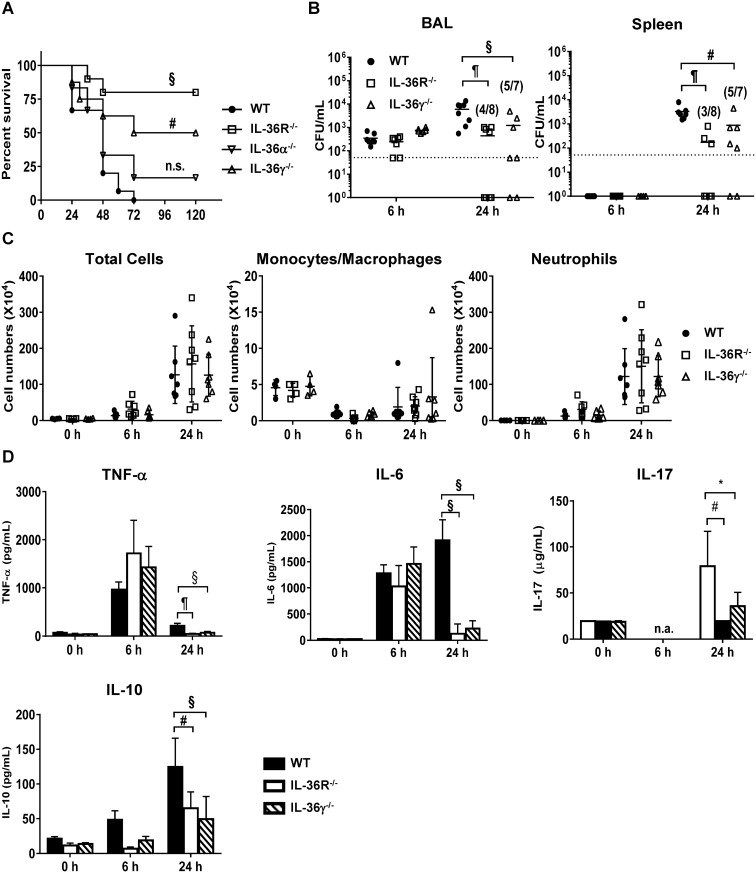
IL-36 receptor and IL-36γ deficient mice were resistant to acute P. aeruginosa infection.WT, IL-36 receptor deficient (IL-36R-/-) and IL-36γ deficient (IL-36γ-/-) mice were intratracheally infected with 2.0 × 105 CFU P. aeruginosa. (A) Survival rate were assessed every 12 h following P. aeruginosa infection. Each group consisted of 6–10 mice. Survival curves were analyzed using the log-rank (Mantel–Cox) test. (B) Bacterial burden in BAL (left upper) and bacterial dissemination in spleen (left panel) were assessed by subsequent dilution method (n = 6–8 per each group). 50 CFU/mL is the limit of detection. Horizon bar indicate mean values. (C) The number of total cell (left panel), neutrophils (middle panel) and monocytes and macrophages (right panel) in BAL were counted at 0 h, 6 h and 24 h after infection. Each group consisted of 4–8 mice. (D) The production of TNF-α, IL-6, IL-10 and IL-17 were measured by ELISA (n = 4–8 each group). (C, D) Data are shown as mean (B) or means ± SD. # p<0.01, § p<0.001, ¶ p<0.0001, n.s.:not significant, n.a.: not available, compared with infected in WT mice or as indicated.